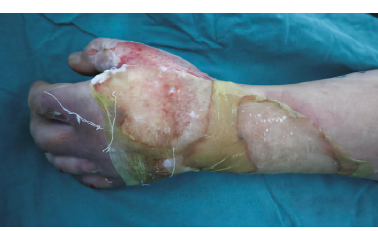
Figure 5: 3d after